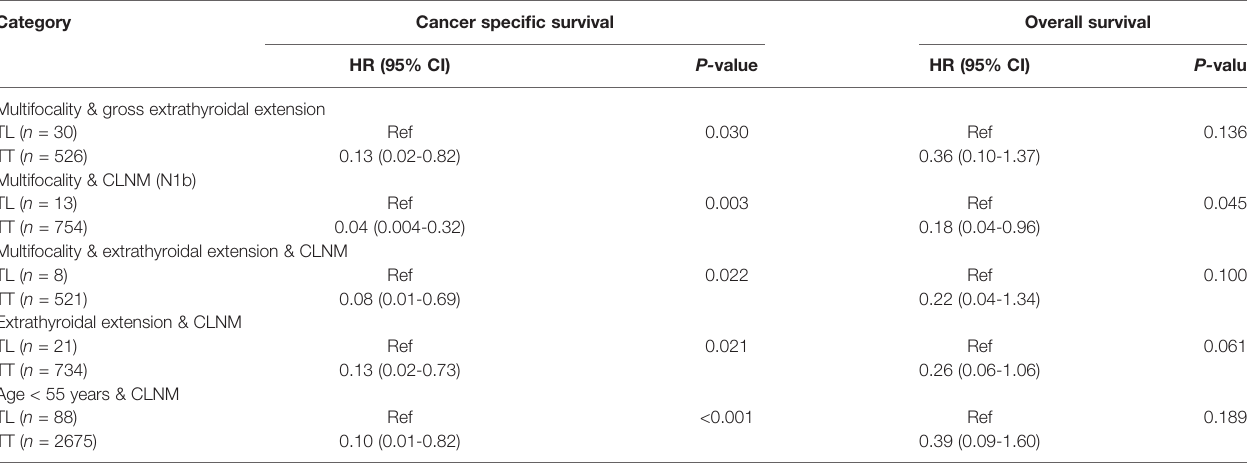
TABLE 4 | The prognosis of PTMC patients according to the extent of surgery by subgroup analysis strati fi ed by clinicopathologic factors by multivariate Cox regression. Category